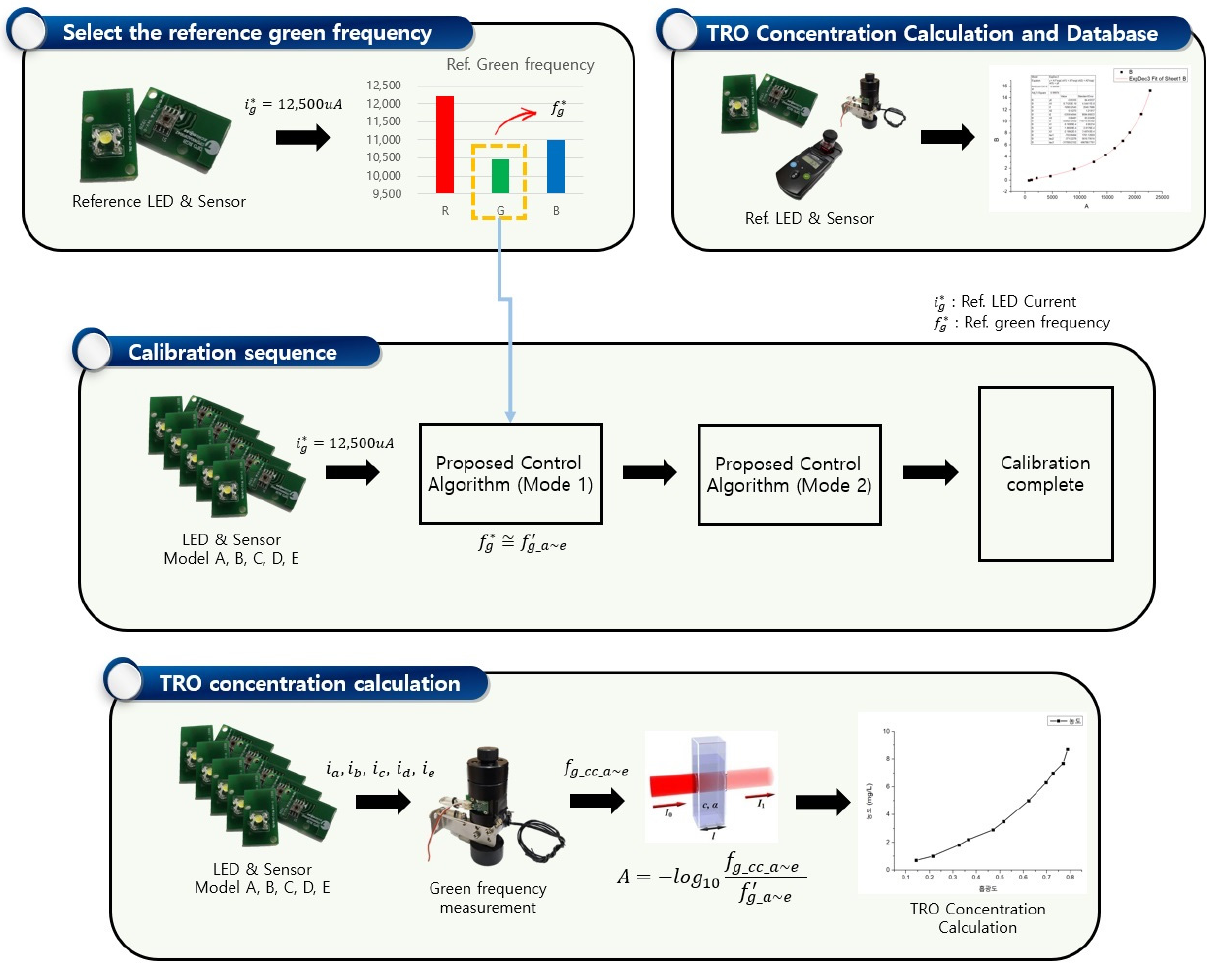
Figure 5. Operation sequence for calibrating LED module and calculating TRO concentration.